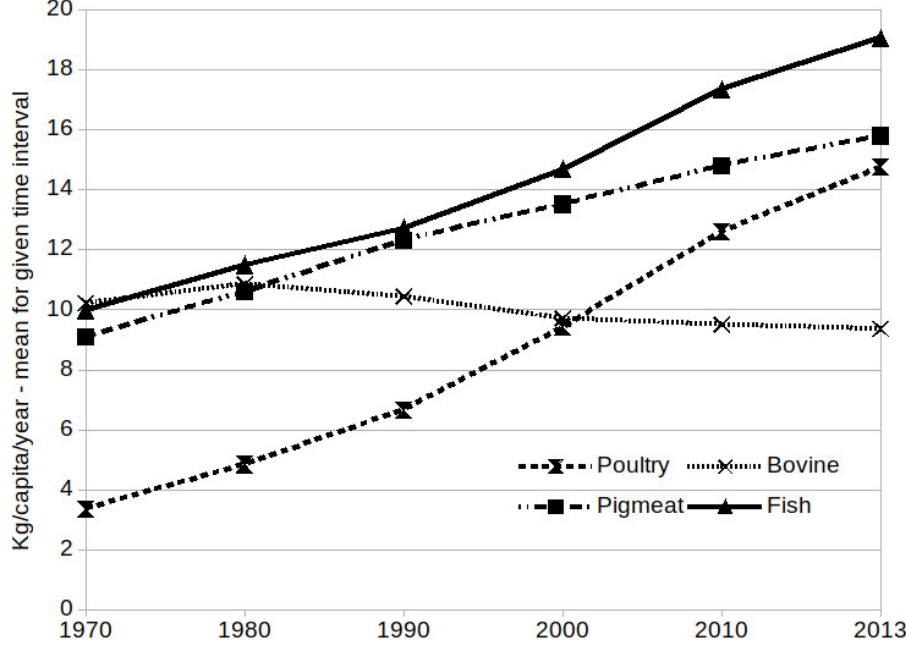
Figure 1. Meat consumption per inhabitant—worldwide data. Source: see [65].